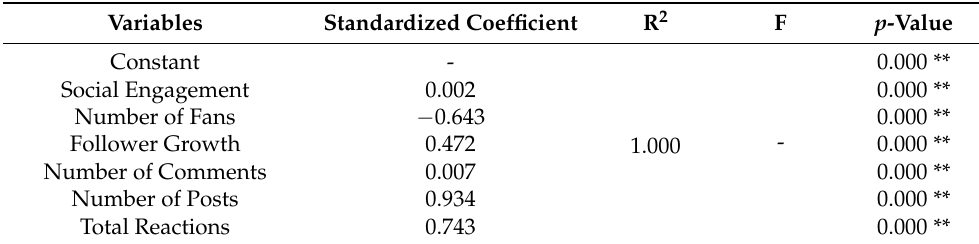
Table 8. Impact of social media analytics on CPNs websites’ bounce